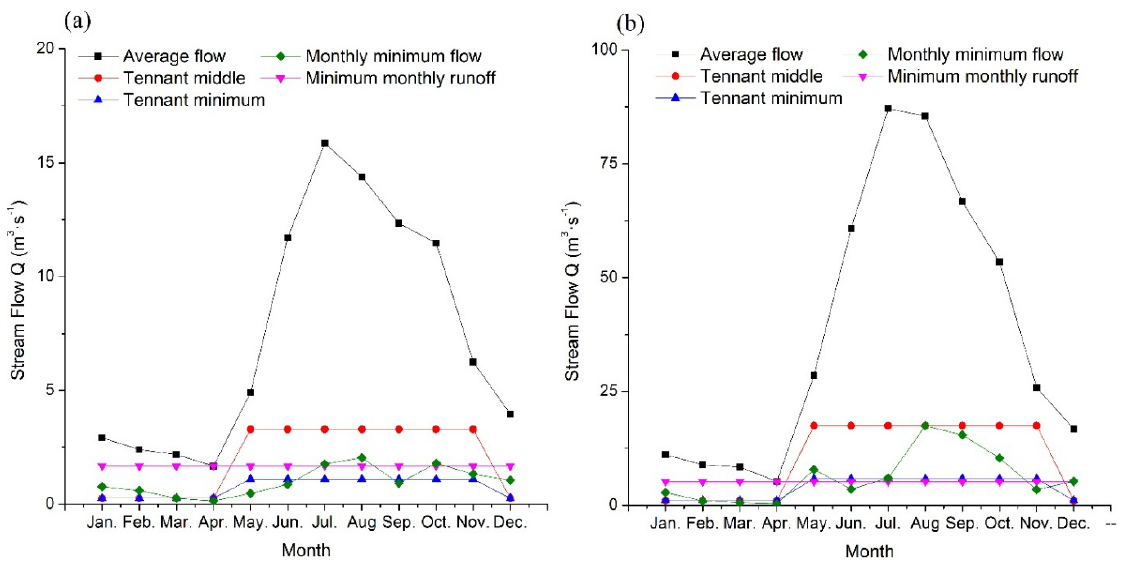
Figure 3. The average flow and ecological flows calculated by 4 methods in Zhanyi ( a ) and Xiqiao ( b ) hydrological